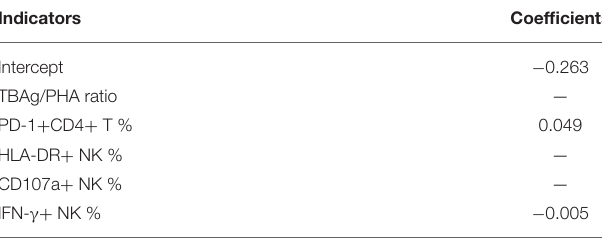
TABLE 4 | IS model for discrimination between EPTB and